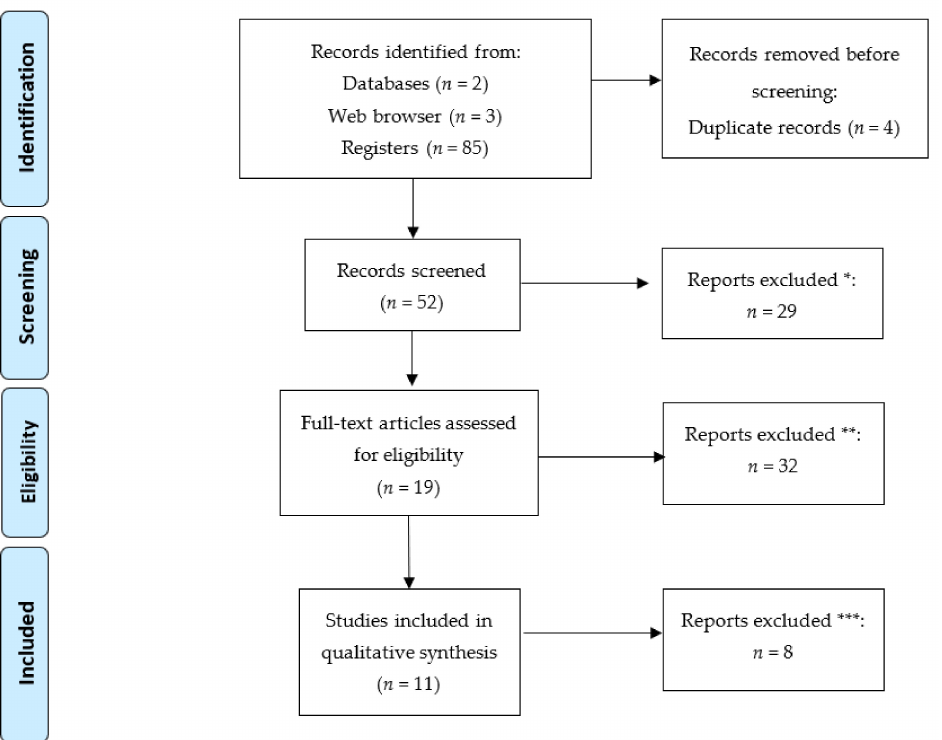
Figure 1. Flow diagram. * Studies excluded after reading title and abstract. ** Studies on other animals as well as horses; studies on other disorders. *** Studies excluded after reading the complete